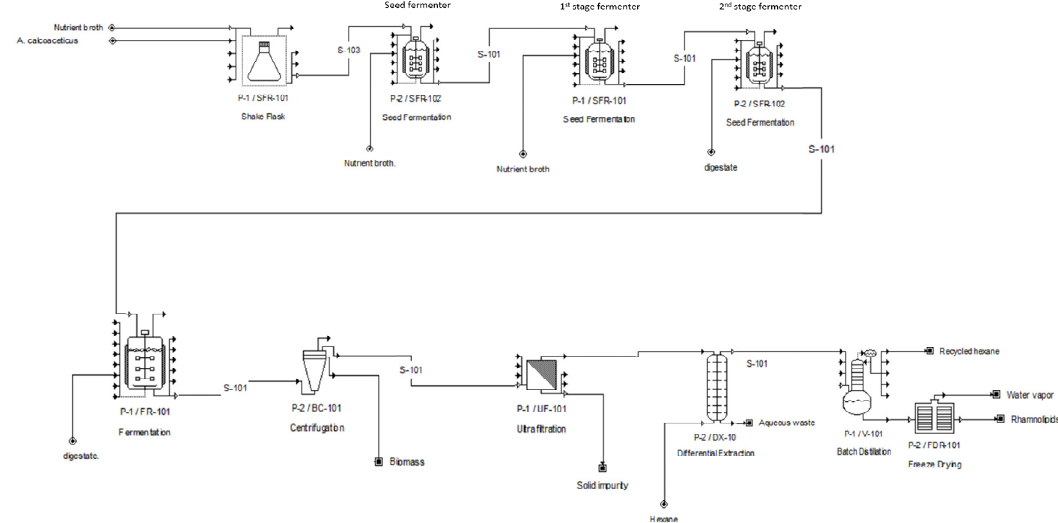
Figure 2. Process flow diagram for rhamnolipids fermentation using food waste